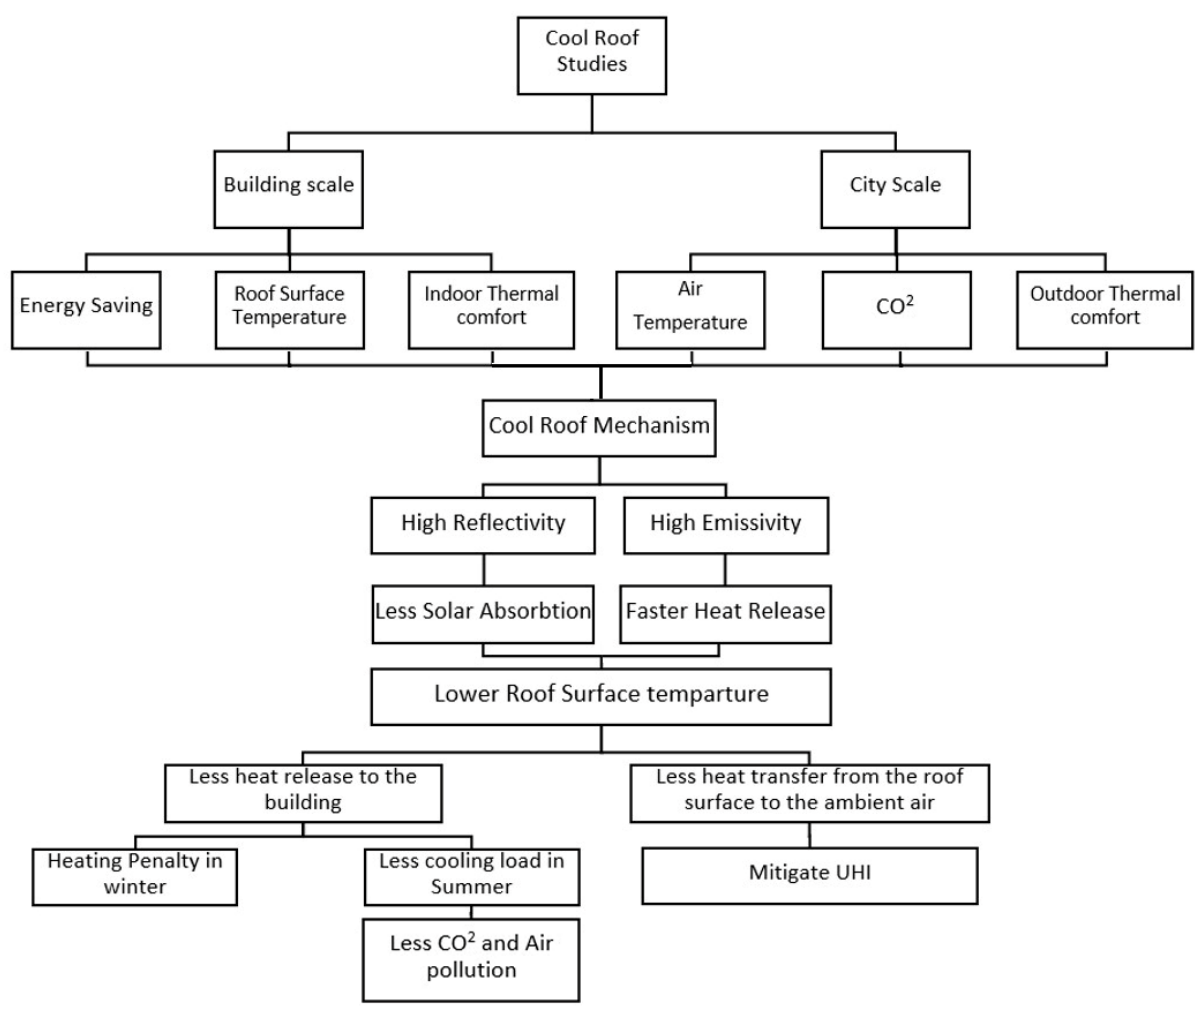
Figure 3. Overall interrelation of the cool roof mechanism at the building and urban scales.